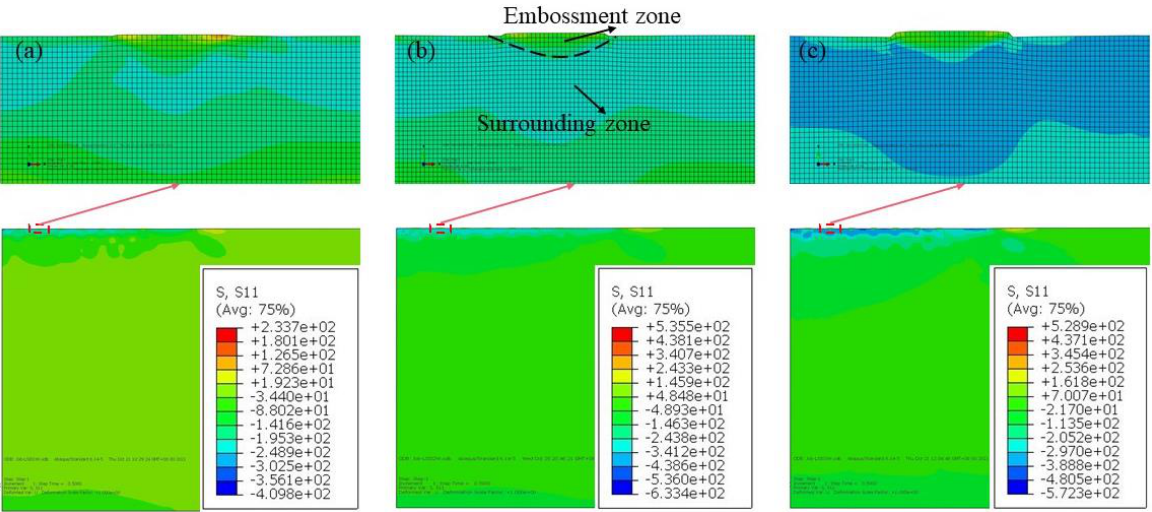
Figure 8. Residual stress distributions inside the sample and around the specific embossment at different peak pressures: ( a ) 3 GPa, ( b ) 4 GPa and ( c ) 5 GPa.